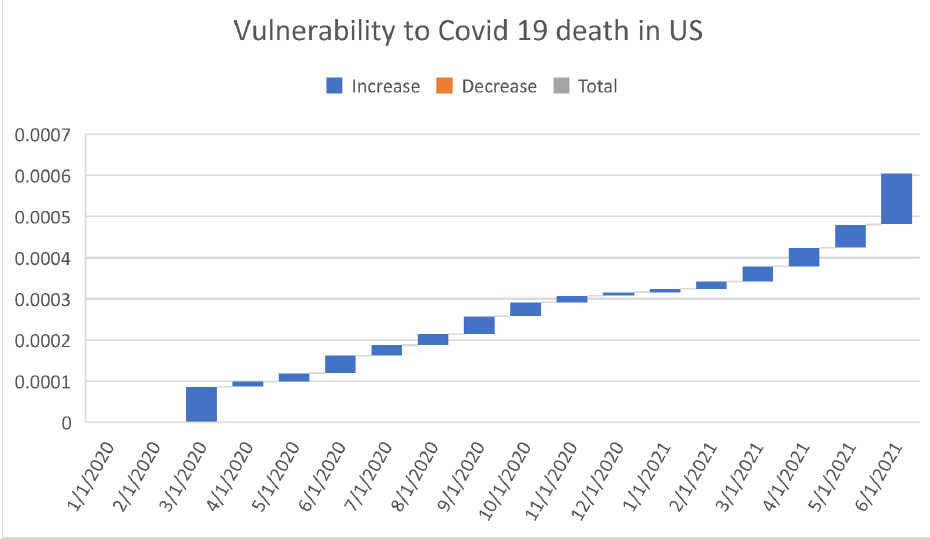
Figure 13. Progressive vulnerability to COVID ‐ 19 deaths in US. For readability, note that 4/1/2020 refers 1 April 2020.